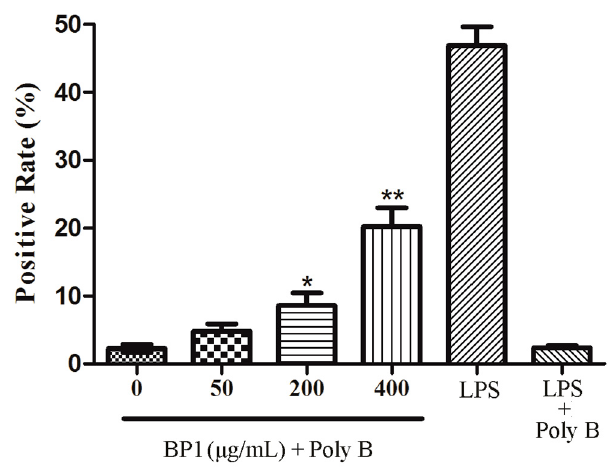
Figure 8. Inducing the effect of BP1 on the phagocytosis to FITC-labeled dextran (12 kDa) by RAW 264.7 cells in a dose-dependent manner. LPS (2 µg/mL) and LPS + polymyxin B served as the positive control and endotoxin-excluded control, respectively. Each value is expressed as the mean ± SD ( n = 3). Level of significance: * p < 0.05, ** p < 0.01 compared to untreated cells (at 0 µg/mL).